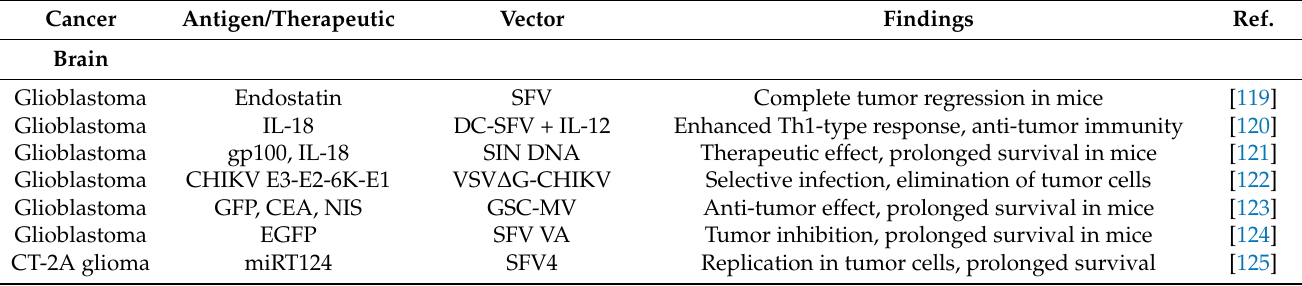
Table 3. Examples of preclinical studies on self-replicating RNA viral vector vaccines against cancers.